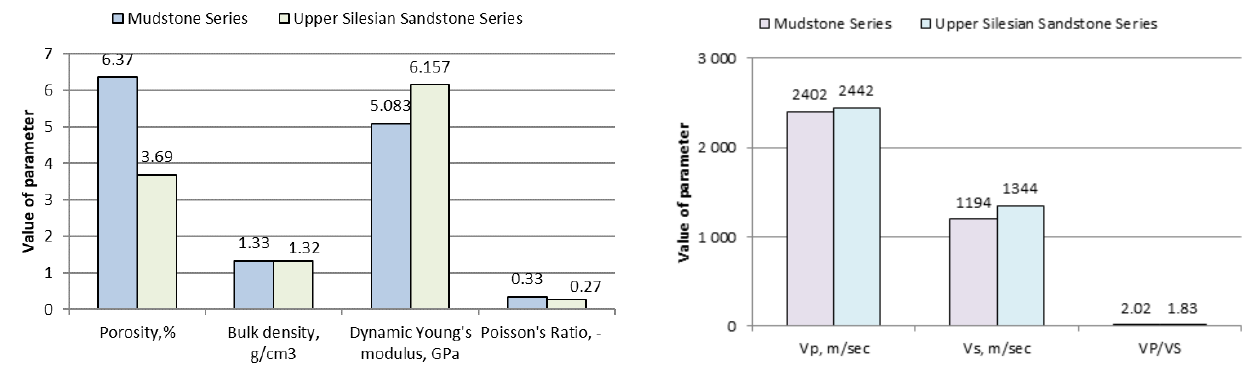
Figure 8. Mean petrophysical dynamic parameter of the tested coals.